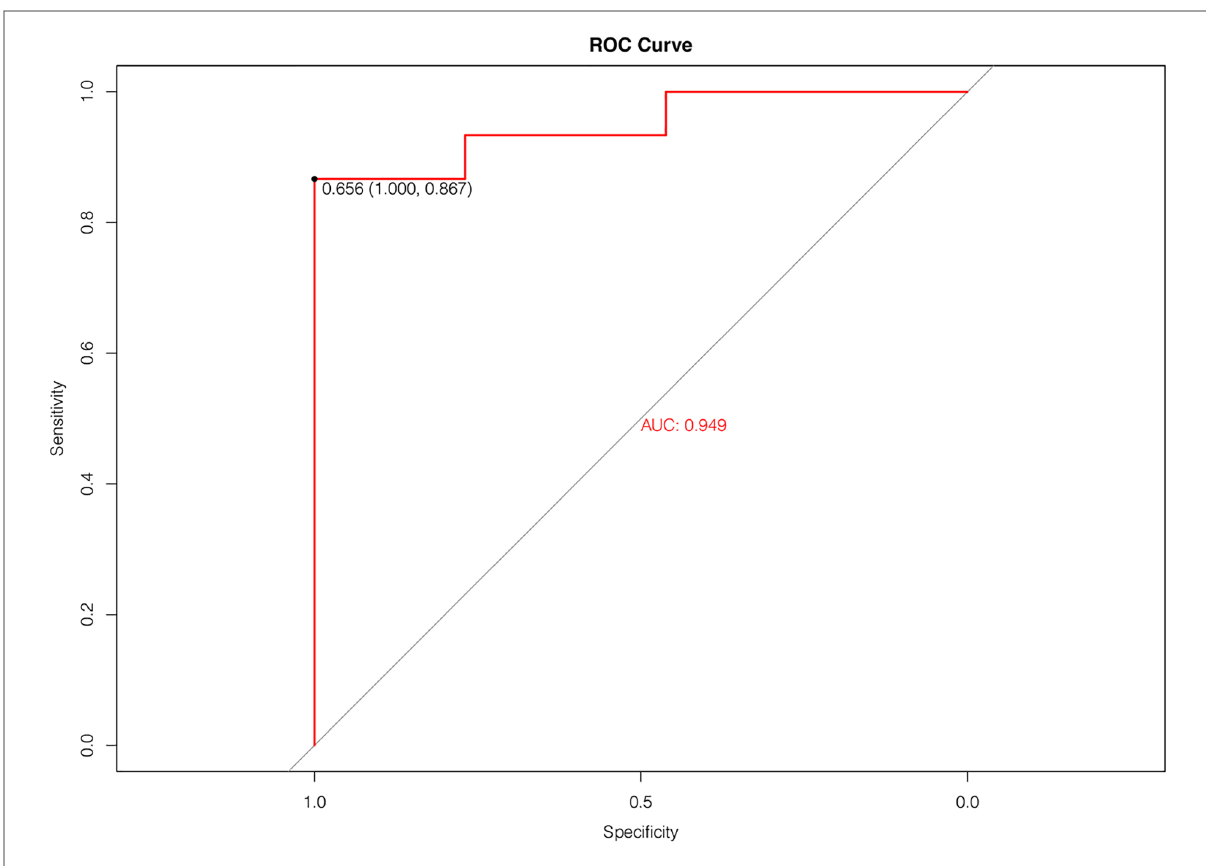
FIGURE 3 ROC curve of the prediction model we